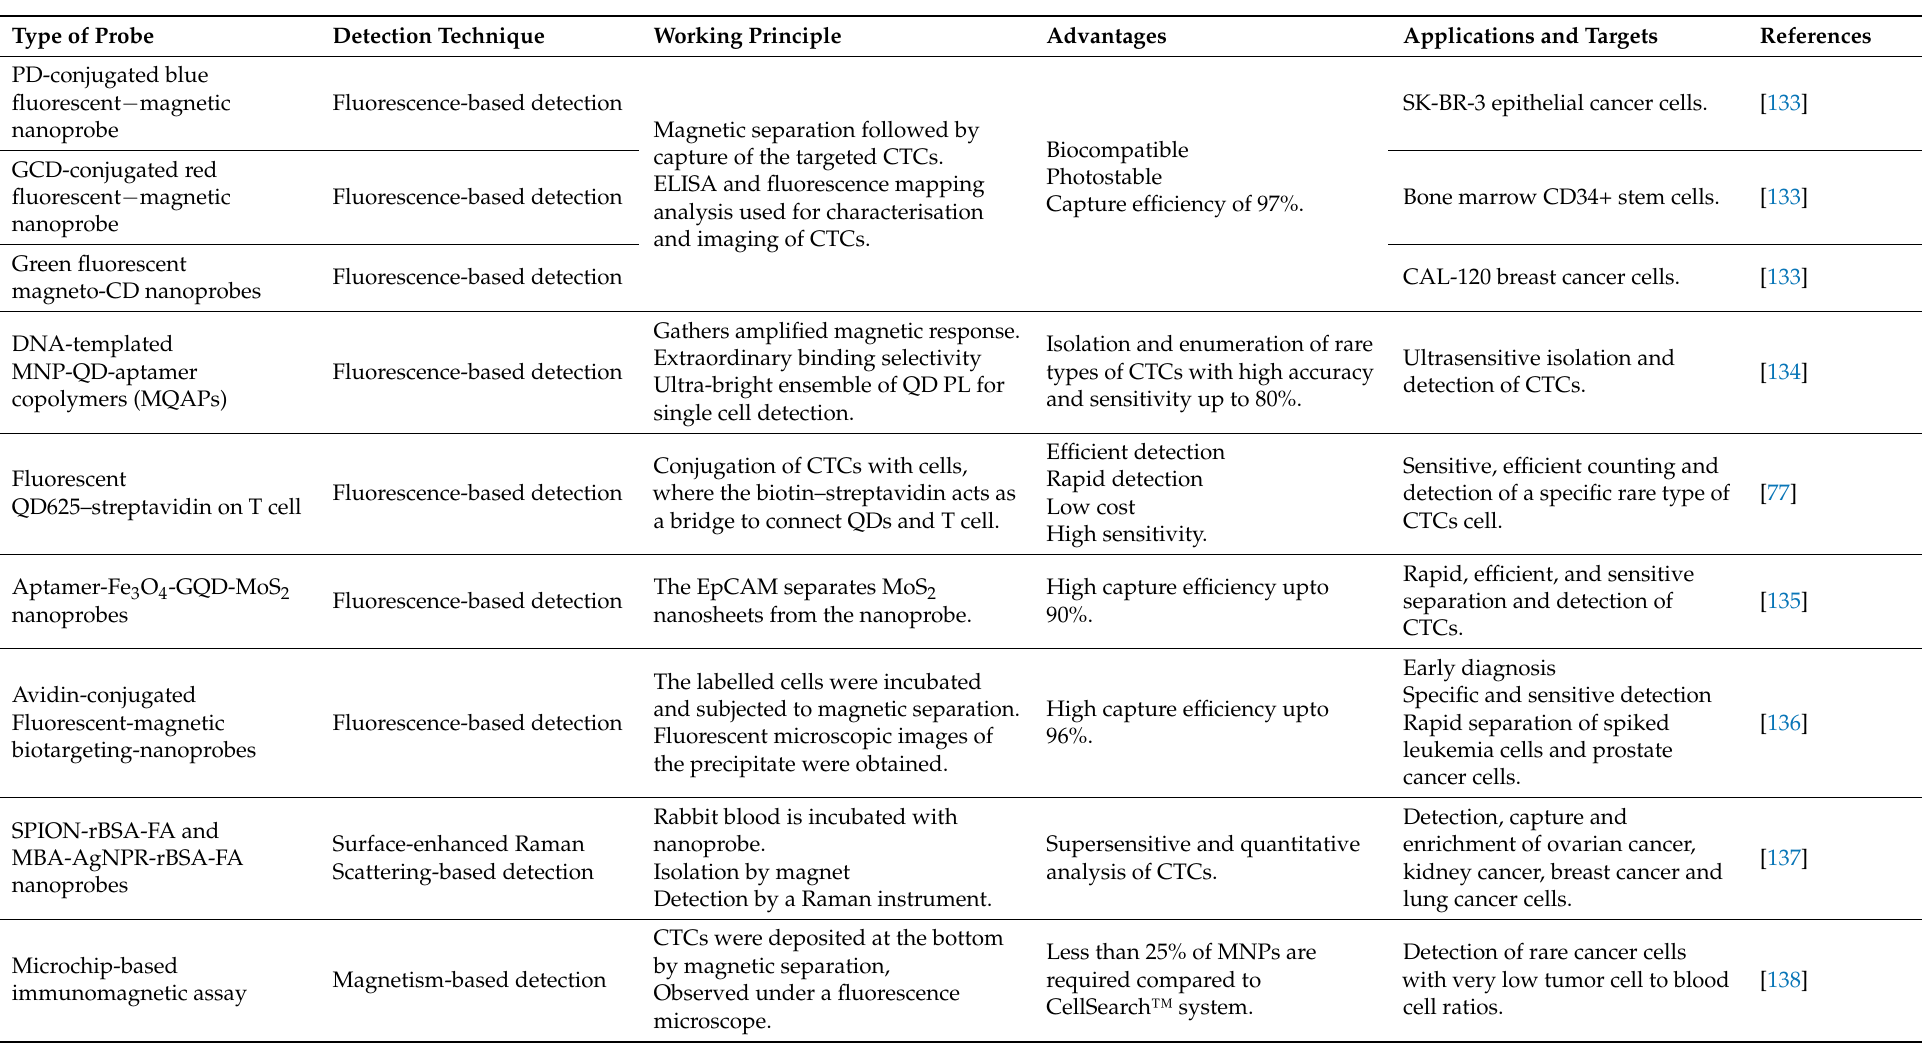
Table 3. List of various probes based on fluorescence, magnetic, surface-enhanced Raman scattering, surface plasmon resonance-based techniques for detection of